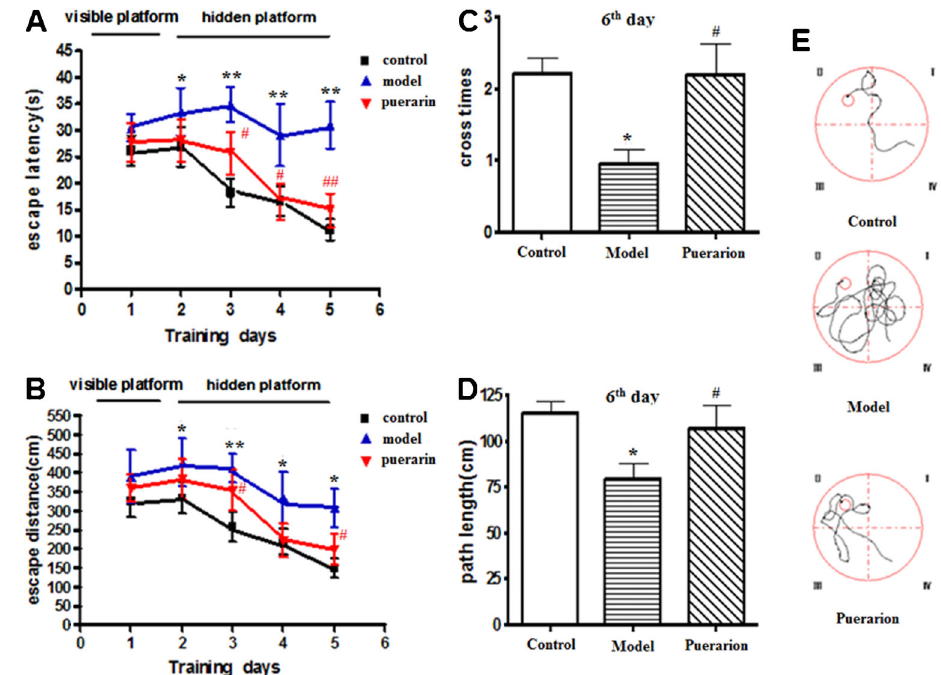
Figure 2. Results of the Morris water maze test. A , Escape latency: time to reach the hidden platform. B , Escape distance: length of the swimming path taken to find the platform. C , Cross times: times the mice passed through the platform. D , Total swimming distance in controlled time (1 min). E , Typical escape route (the swimming path of mice) in the 3 groups. *P , 0.05, **P , 0.01 vs control group; # P , 0.05, ## P , 0.01 vs model group (one-way ANOVA).